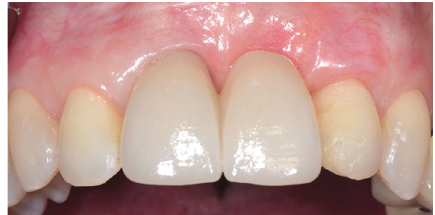
Figure 19: Final results, 16 months after the fi rst mucogingival surgery.